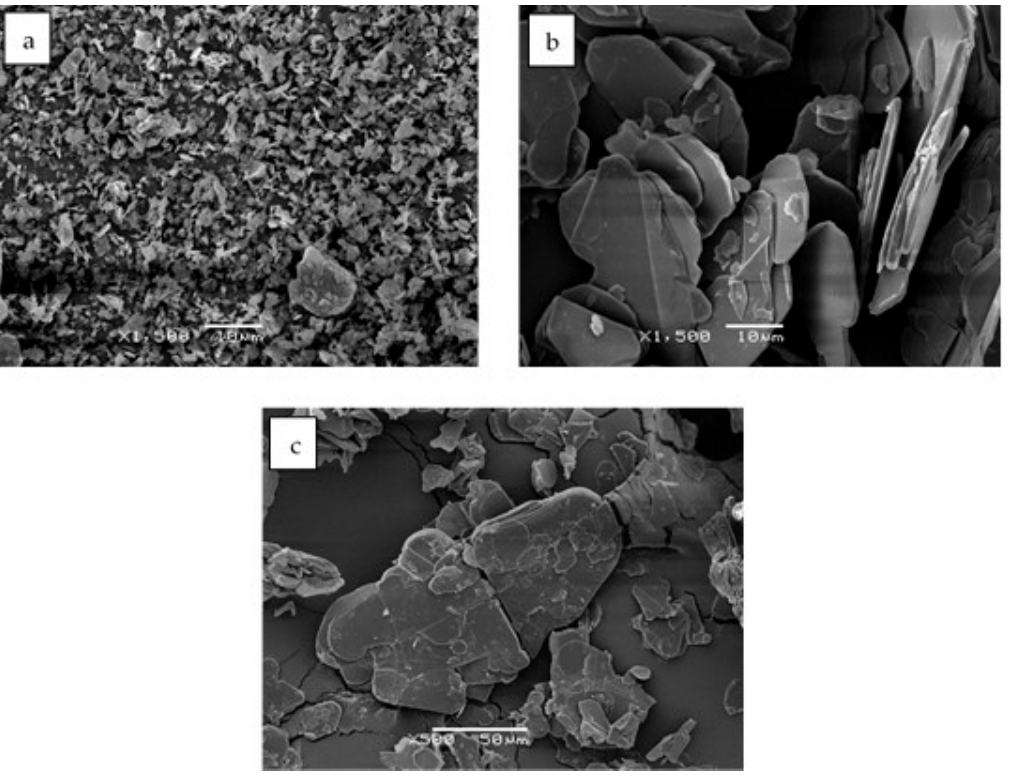
Figure 1. Scanning Electron Microscopy (SEM) images of the as-received BN platelet particles: ( a